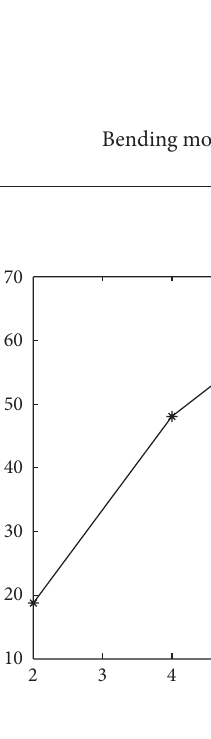
Figure 4: Effect of initial pH ( 𝐶 0 : 200 mg/L; 𝑉 : 100mL; 𝑀 : 0.3 g).